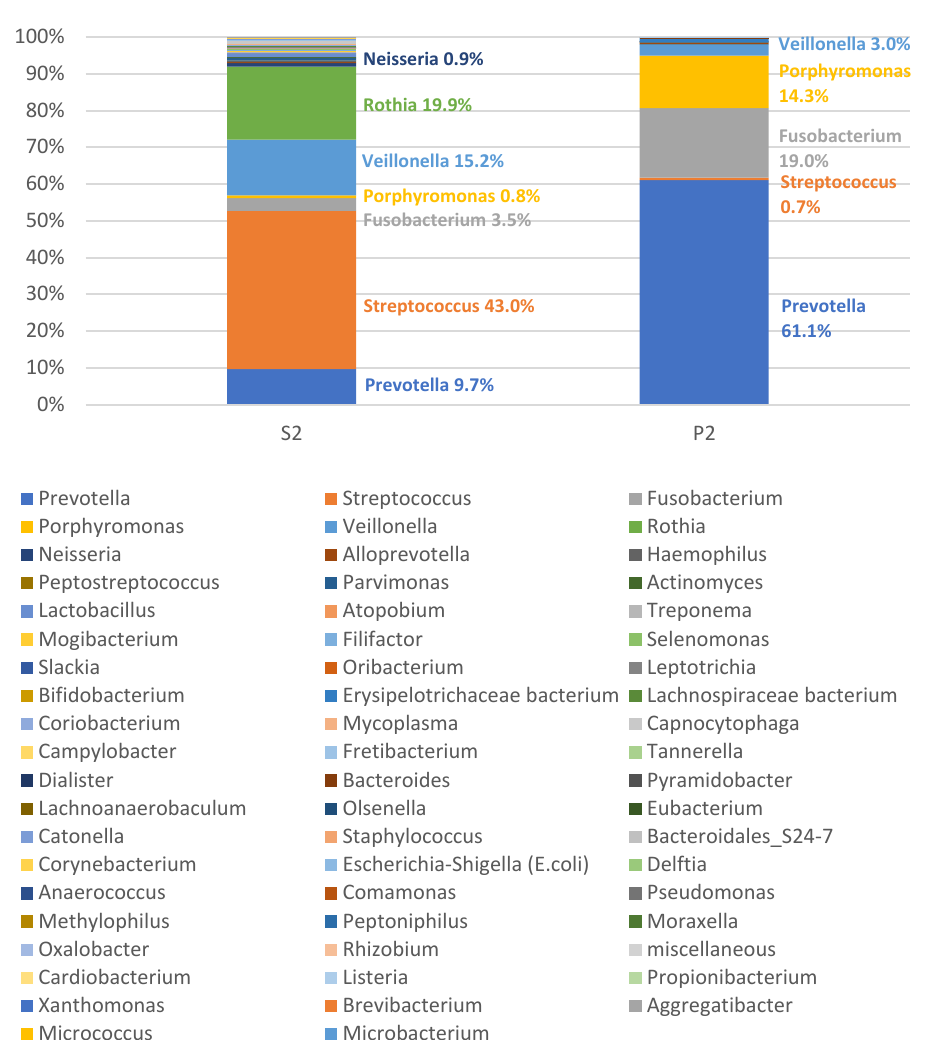
Figure 4. Microbiome of the saliva (S2) and the pus (P2) of patient no. 2. The microbiome of the pus shows the typical picture of a polymicrobial infection. The legend contains all detected bacterial genera of the two related samples. The order in the legend corresponds to the total abundance in saliva and pus of all 50 samples (decreasing from left to right).